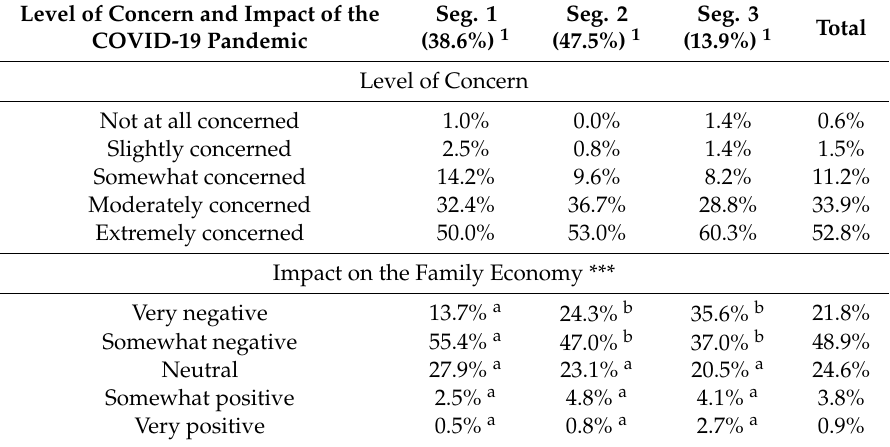
Table 6. Level of concern and impact of the COVID-19 crisis in Spain.